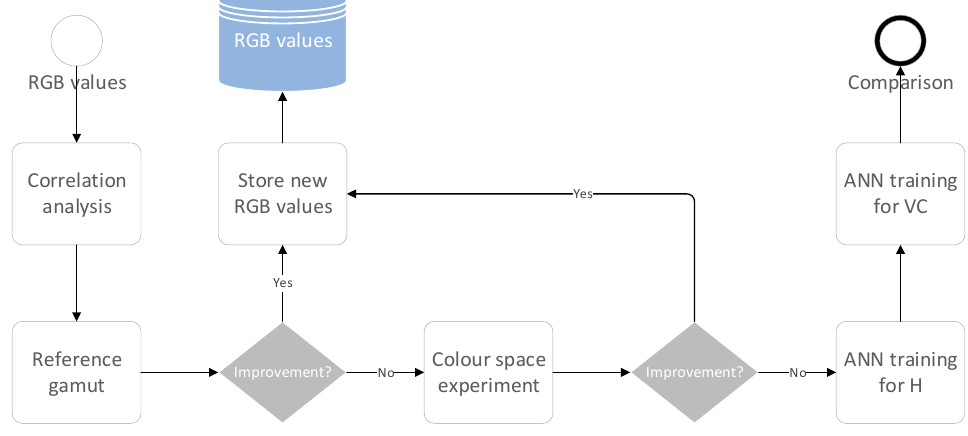
Figure 4. Overview of the designed experiments.